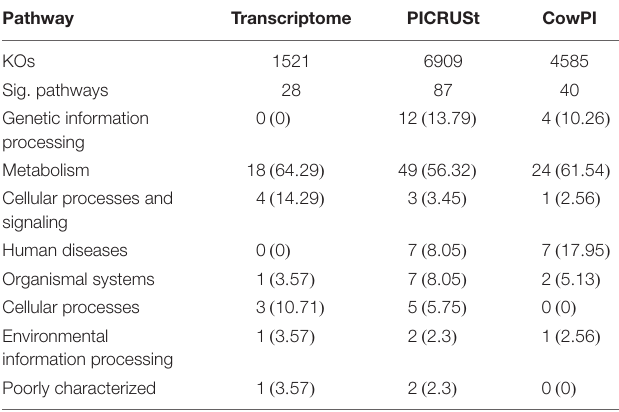
TABLE 1 | Significant Pathways in each dataset, numbers in parentheses represent percentage of significant pathways within that dataset. Pathway Transcriptome PICRUSt